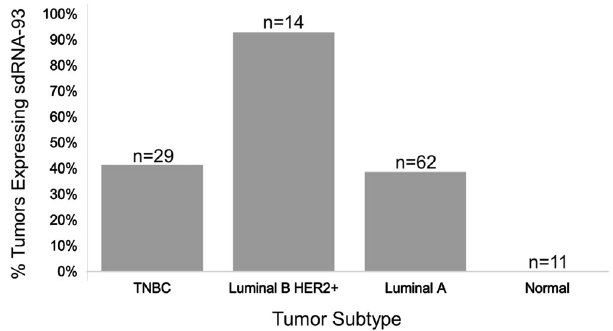
Fig. 6 SdRNA-93 expression in distinct breast cancer subtypes. In all, we determined sdRNA-93 expressions in 116 small RNA-seq fi les corresponding to 116 breast cancer patient tumors and/or normal breast tissue controls. SnoRNAs were counted as signi fi cantly expressed if counts were ≥ 250 counts/million reads. The number of sequencing fi les/patient samples corresponding to a particular subtype are indicated ( n = ). Percentage was calculated as the number of samples signi fi cantly expressing sdRNA-93/total number of samples of that